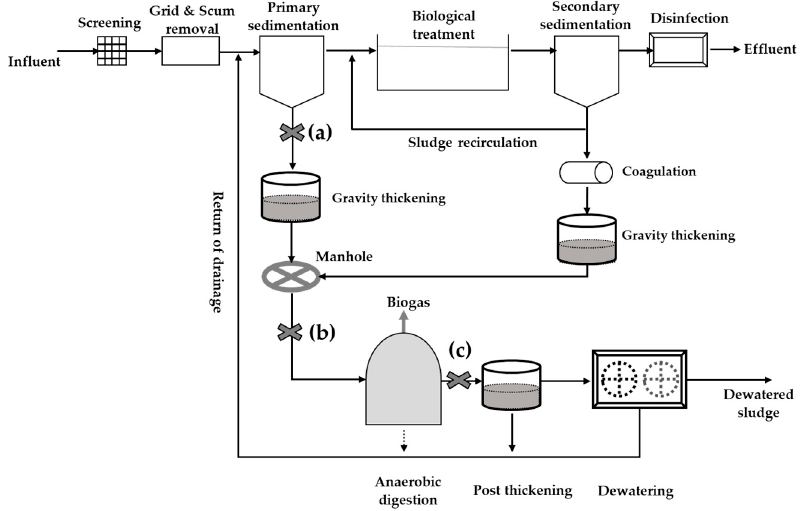
Figure 1. Flow diagram of Thessaloniki’s Municipal Wastewater Treatment Plant and sampling points: ( a ) primary sludge, ( b ) mixture of primary and secondary sludge, ( c ) inoculum.